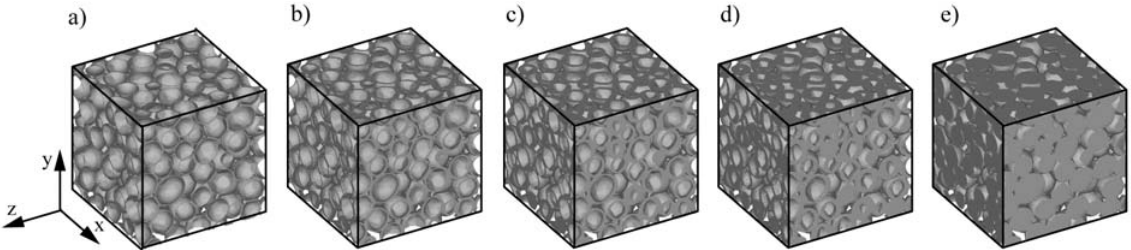
/ r = 0.066, ρ w = 0.63; ( e ) t r